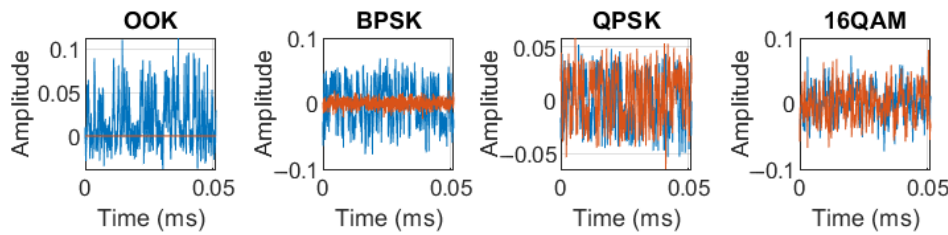
Figure 5. Amplitude of the real and imaginary parts of the example frames against the sample number. The blue lines are for the real part, while the red ones are for the imaginary part. Weak turbulence with SNR = 10 is as an example above.